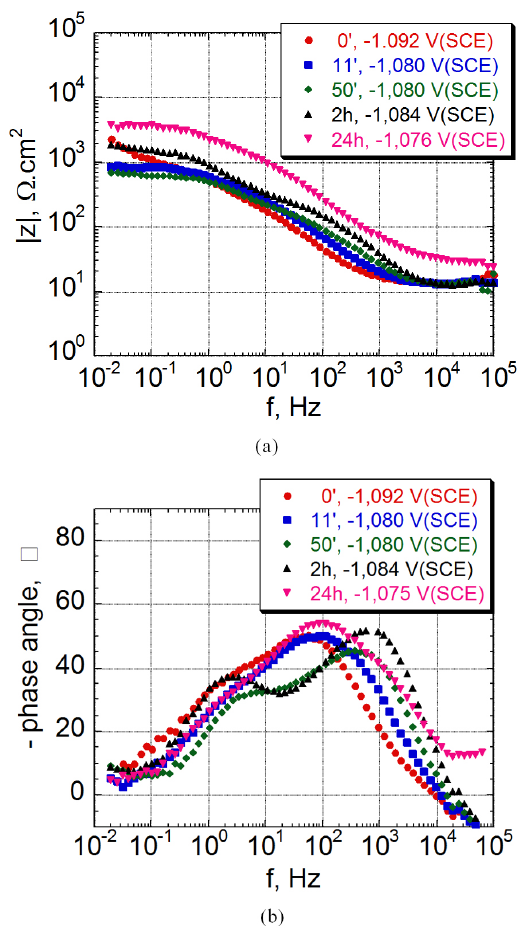
Figure 5. (a) Bode magnitude and (b) phase angle plots a function of SO , pH 10, solution, immersion time in aerated 0.3 mol.L –1 Na 2 4 phosphatized electrogalvanised steel coating – sample protected with treatment